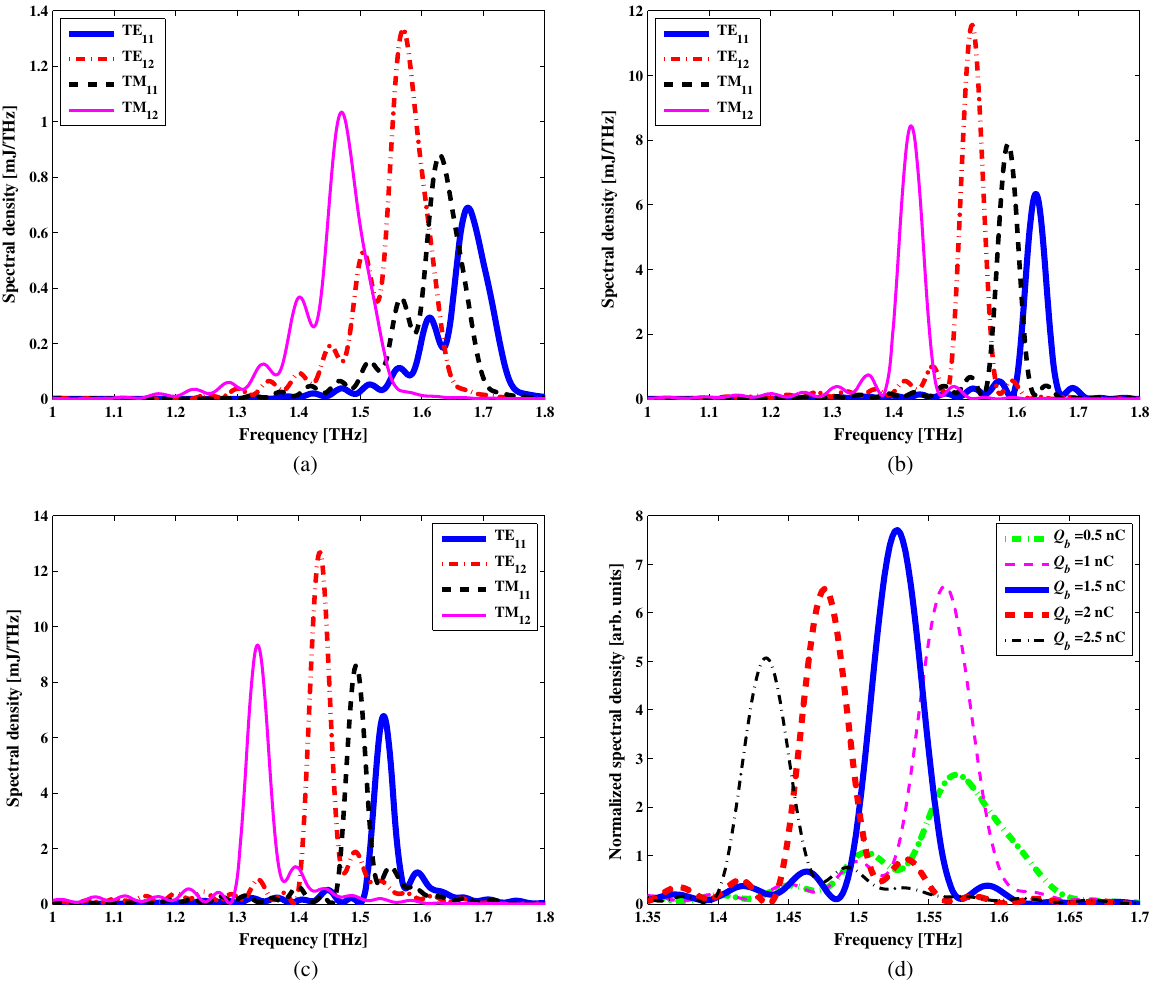
FIG. 5. Spectral radiation density d W= d f for charges 0.5 nC (a), 1.5 nC (b), and 2.5 nC (c) obtained after 40 undulator periods. Þ d W= d f of the TE Normalized spectral density ð 1 =q 12 waveguide mode (d) is given for comparison. b